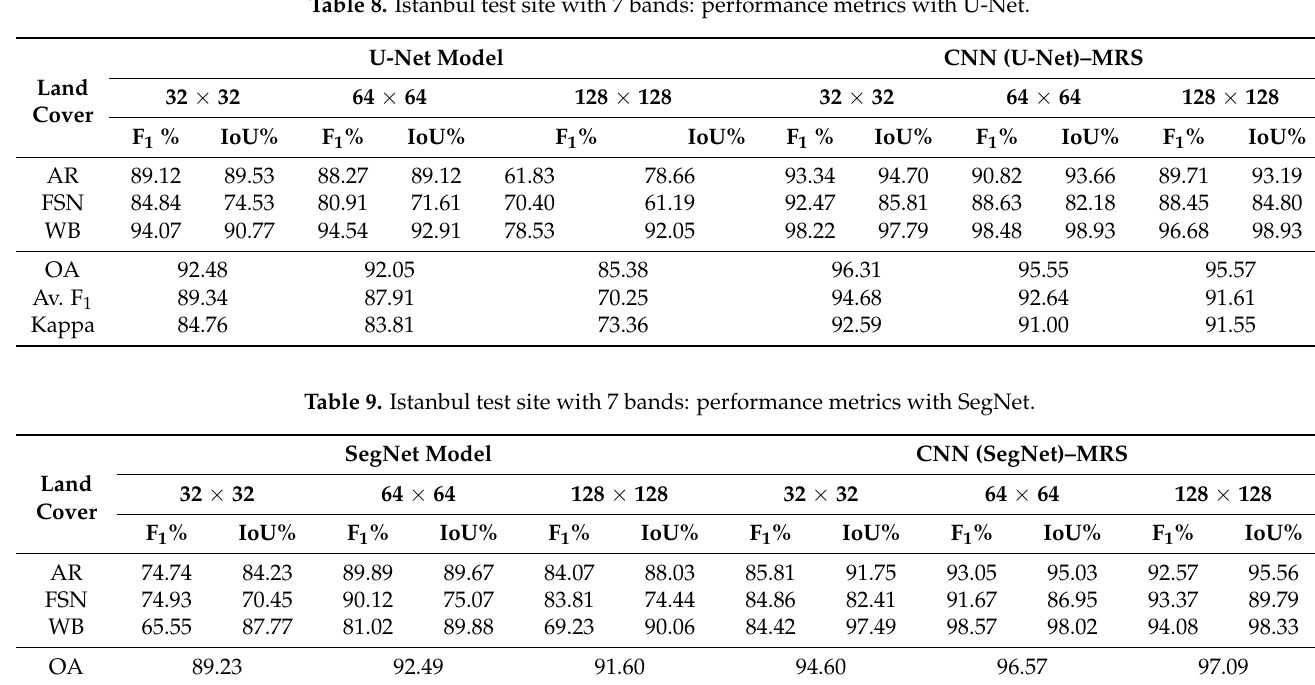
Table 8. Istanbul test site with 7 bands: performance metrics with U-Net.